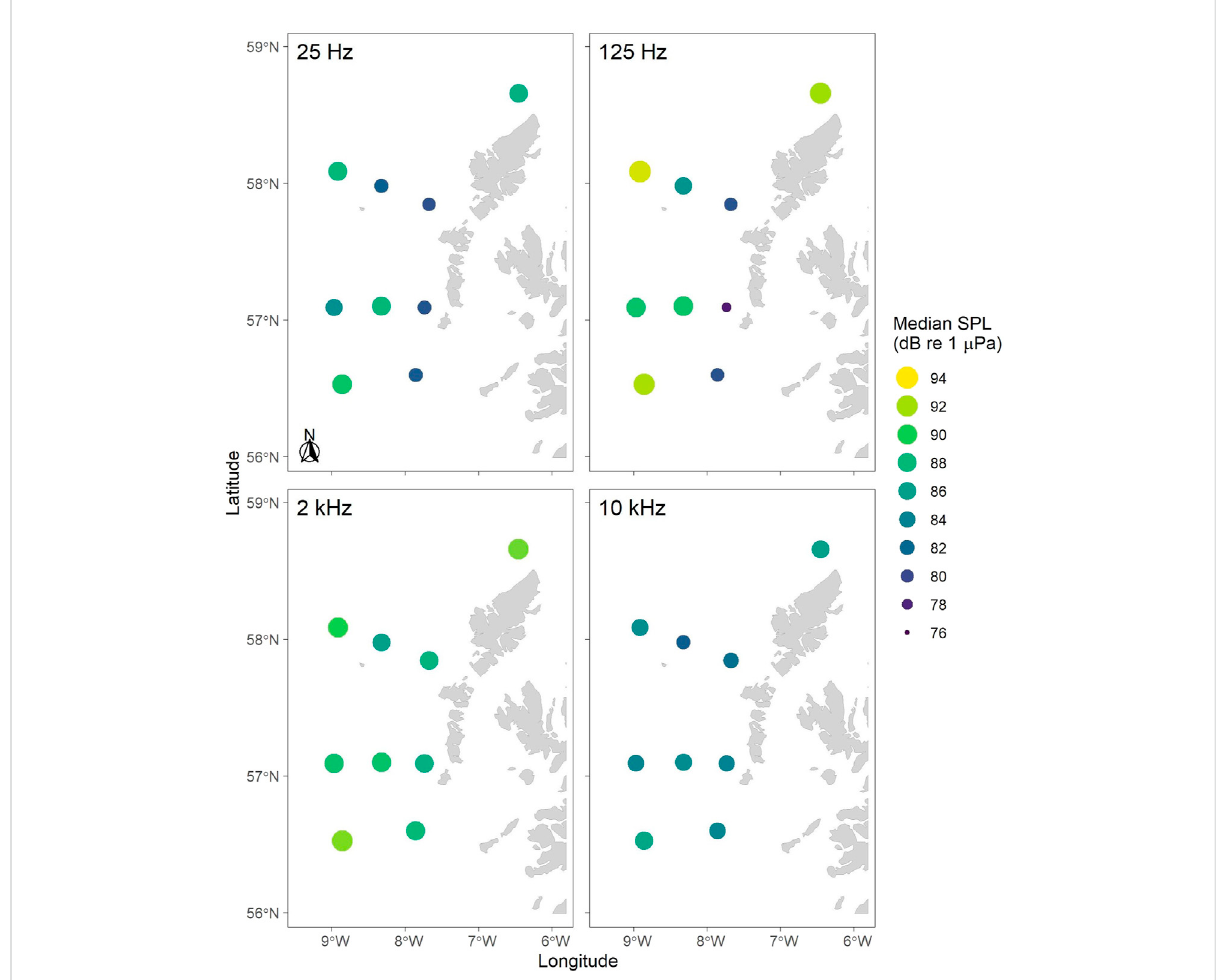
FIGURE 6 Median root-mean-squaresoundpressurelevels (L p ,rms ;dBre1 μ Pa) mapped across thewhole recording period(i.e. 8-12 months; seeTable 1) for four 1/3-octave bands centred at 25 Hz, 125 Hz, 2 kHz and 10 kHz mapped by recording location. Colours (dark to light) and circle size (small to big) indicate increase in sound pressure